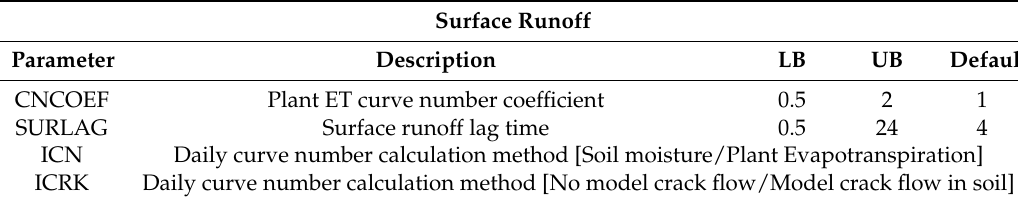
Table A2. Adjustable SWAT parameters for surface runoff functions. Surface Runoff